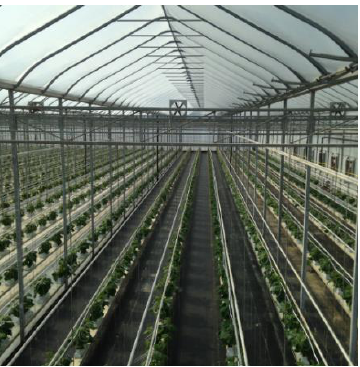
Figure 1. Rows of cucumber plants in the greenhouse.